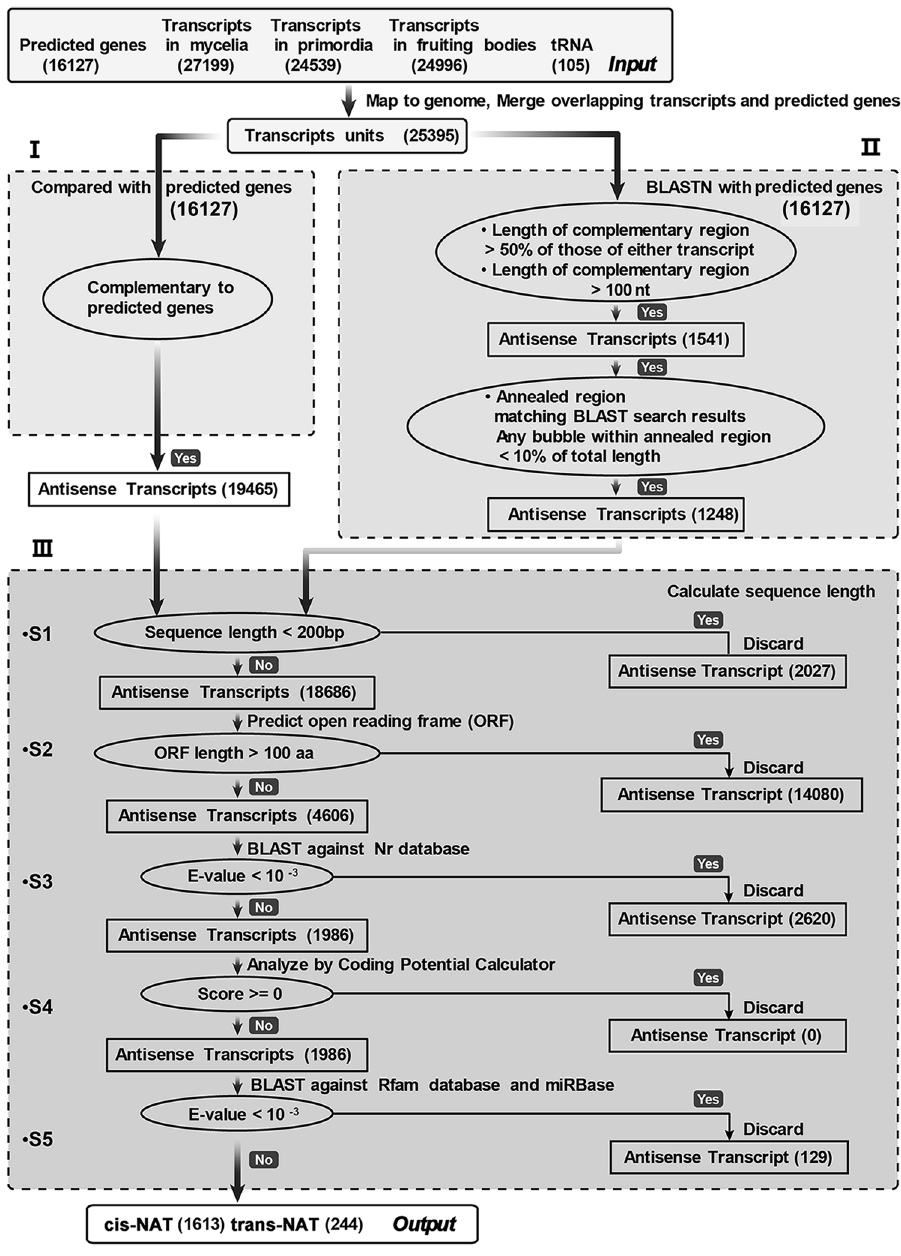
Figure 1. Bioinformatic pipeline used to identify NATs in G. lucidum . The pipeline contains three modules. The predicted genes and transcripts were combined to form transcripts units, which were then subjected to the identification of candidate cis-NATs (module I) or candidate trans-NATs (module II). The transcripts were then filtered in five steps to identify non-coding antisense transcripts (module III). The name of the filtering step and the corresponding criterion are shown above and in the corresponding diamond respectively. The number of candidate NATs retained and discarded after each filtering step is shown in parenthesis. ORF, open reading frame; aa, amino